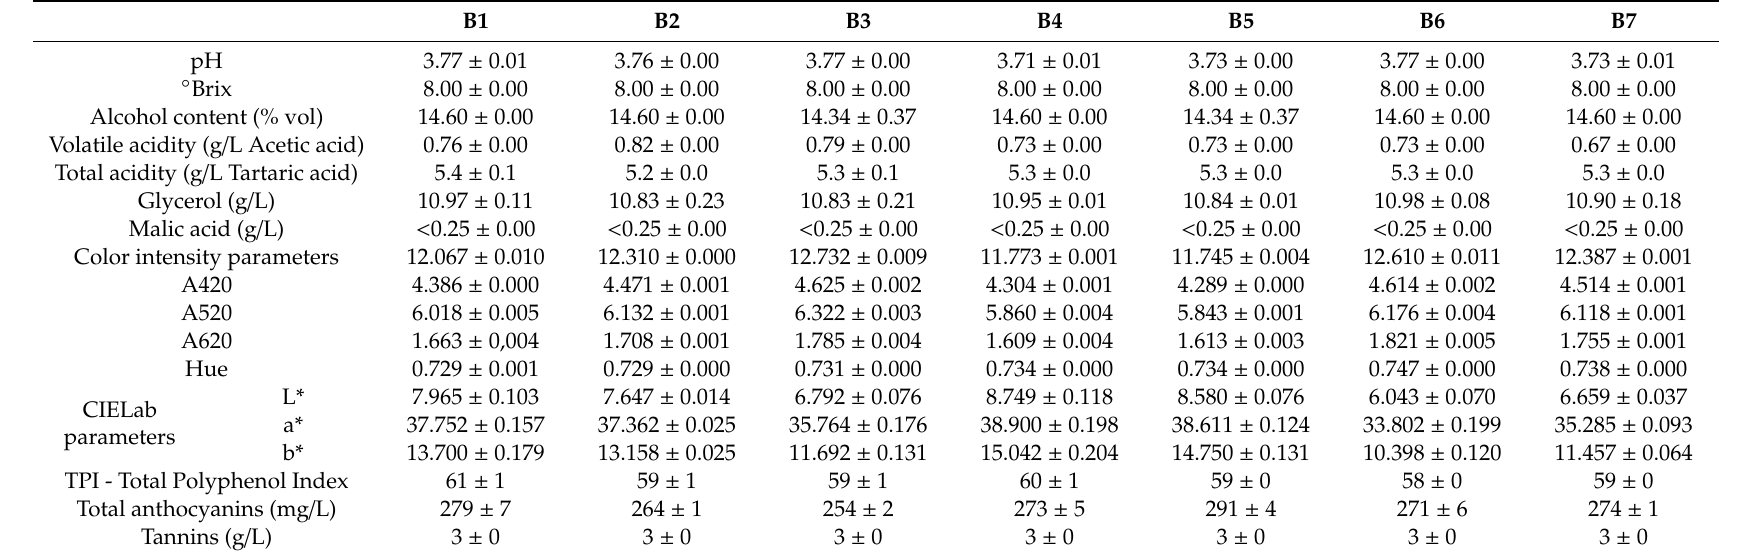
Table 7. Analysis of the physical and chemical parameters of the wine during its aging in the